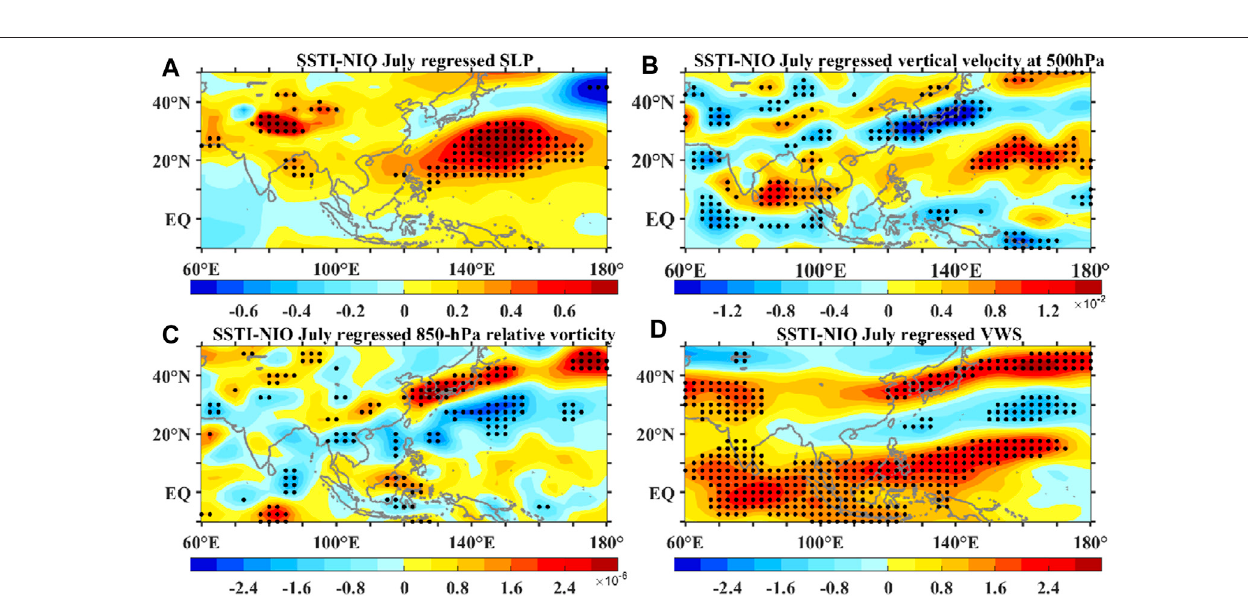
Frontiers in Earth Science |